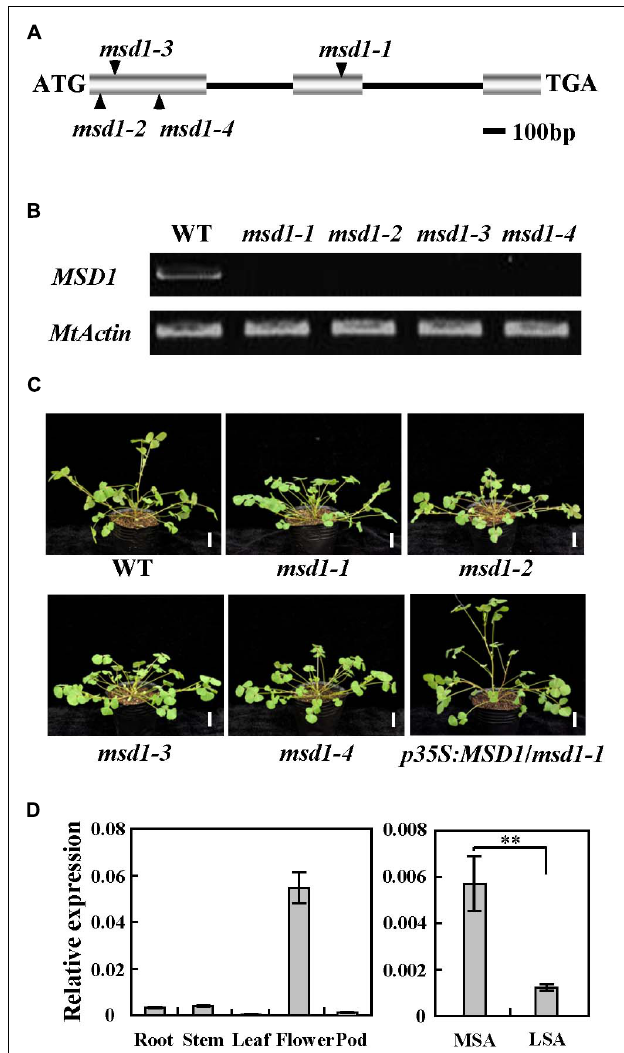
FIGURE 2 | Molecular cloning of the MSD1 gene. (A) Schematic representation of the gene structure of MSD1 and the Tnt1 insertion sites in msd1-1 , msd1-2, msd1-3 , and msd1-4 . (B) RT-PCR analysis of MSD1 expression in wild type (WT) and various msd1 alleles. MtActin was used as the loading control. (C) Phenotypic analysis of WT, msd1-1 , msd1-2, msd1-3, msd1-4 , and msd1-1 plants complemented with p35S : MSD1 . Bars = 2 cm. (D) MSD1 transcript levels in different tissues, as revealed by quantitative RT-PCR. MtActin was used as an internal control. MSA, main shoot apices. LSA, lateral shoot apices. Values are means ± SD of three technical replicates; asterisks indicate significant differences ( ∗∗ P < 0.01, Student’s t- test). Three independent experiments were performed, with similar